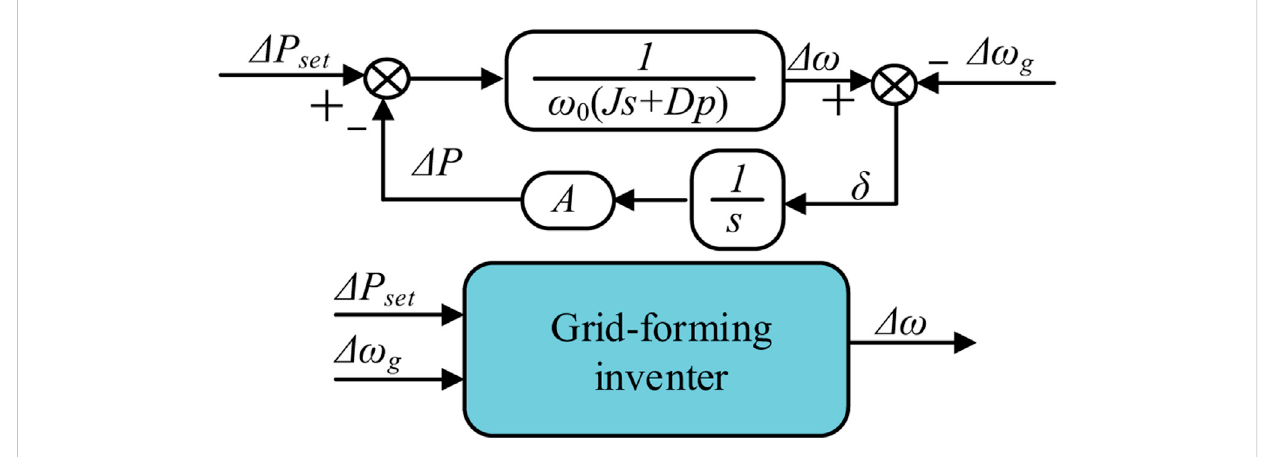
FIGURE 2 Equivalent input and output of the system under small